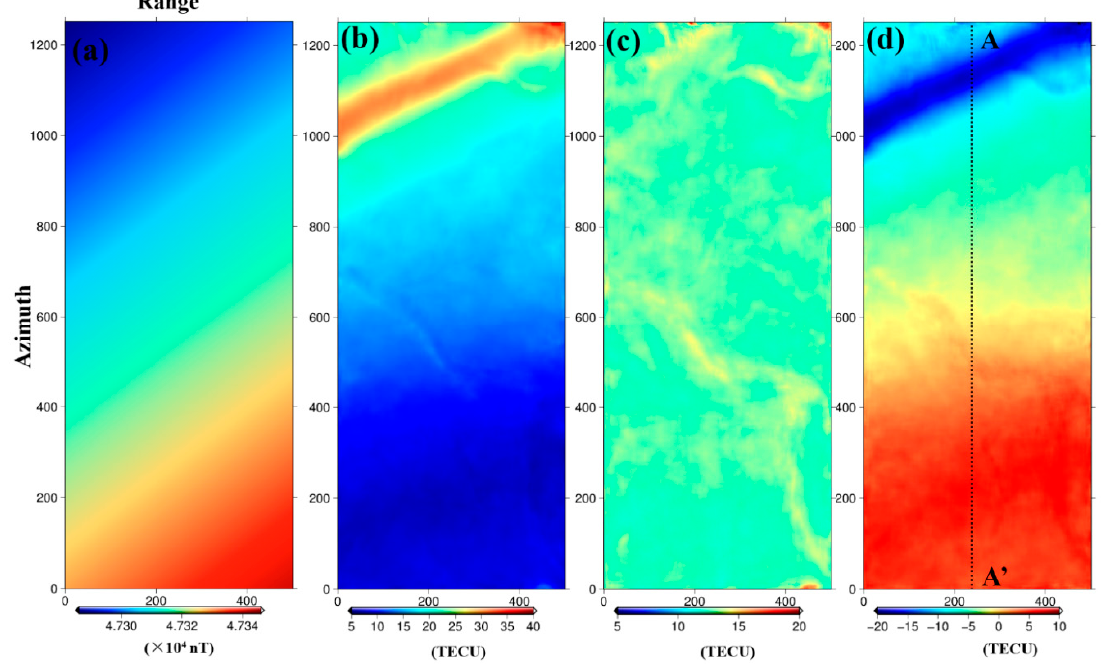
Figure 4. Vertical total electronic content (VTEC) maps inverted from FR angles. ( a ) B value of the geomagnetic field on 1 April 2007; ( b , c ) VTEC maps on 1 April and 17 May 2007, respectively, ( d ) the difference between ( b ) and ( c ).